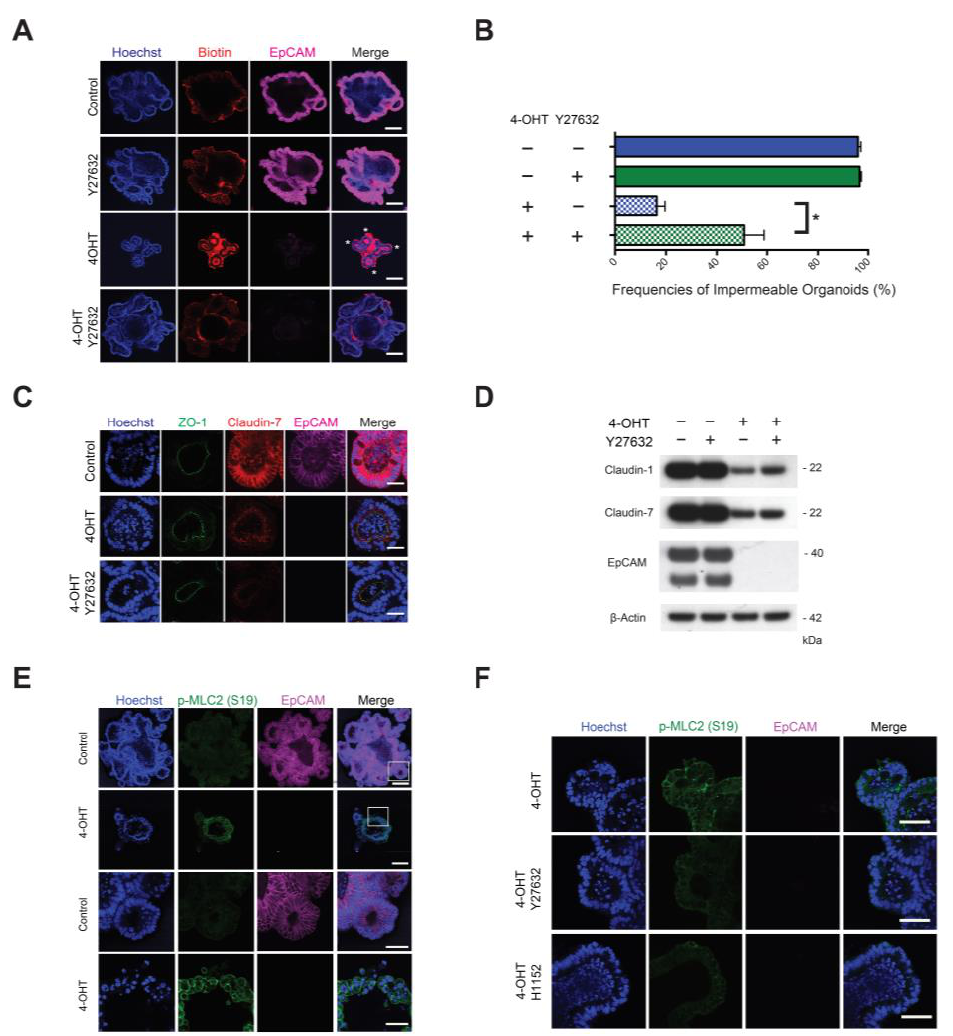
Figure 4. Rho-associated coiled-coil kinase (ROCK) inhibitors attenuate myosin light chain 2 (MLC2) phosphorylation and improve epithelial integrity in EpCAM KO organoids without modulating claudin levels. ( A ) KO organoid permeability to sulfo-NHS-LC-biotin (red) was assessed with, and without, Y27632 treatment. Asterisks highlight labeled budding lumens with compromised epithelial integrity. Bars = 100 µ M. ( B ) Quantitation of Y27632-induced improvement of epithelial integrity. Permeability of organoids to sulfo-NHS-LC-biotin was assessed by confocal fluorescence microscopy. In each condition in each experiment, 50 randomly selected organoids were scored. Data depicted represent aggregate data from three independent experiments (mean ± SEM; * p < 0.05 via Student’s t test). ( C ) Assessment of claudin-7 expression (red) in KO organoids with, and without, Y27632 treatment. Bars = 25 µ M. ( D ) ROCK inhibitor treatment of EpCAM-deficient organoids does not restore EpCAM or claudins expression. Organoid lysates were immunoblotted with anti-claudin-1, claudin-7, EpCAM and β -actin Ab. Representative data from 1 of 3 independent experiments are shown. ( E ) Phosphorylation of MLC2 (S19) (green) in KO organoids on Day 9. Bars = 100 µ M. Lower panels represent expanded views of regions designated in the upper panel. Bars = 25 µ M. ( F ) Inhibition of phosphorylation of MLC2 (S19) (green) in KO organoids by treatment with the ROCK inhibitors Y27632 and H1152 on Day 9. Bars = 25 µ M. EpCAM (pink), Hoechst 33342 (blue) in ( A , C , E , F ). Representative data from 1 of 3 independent experiments are show in ( A , C – F